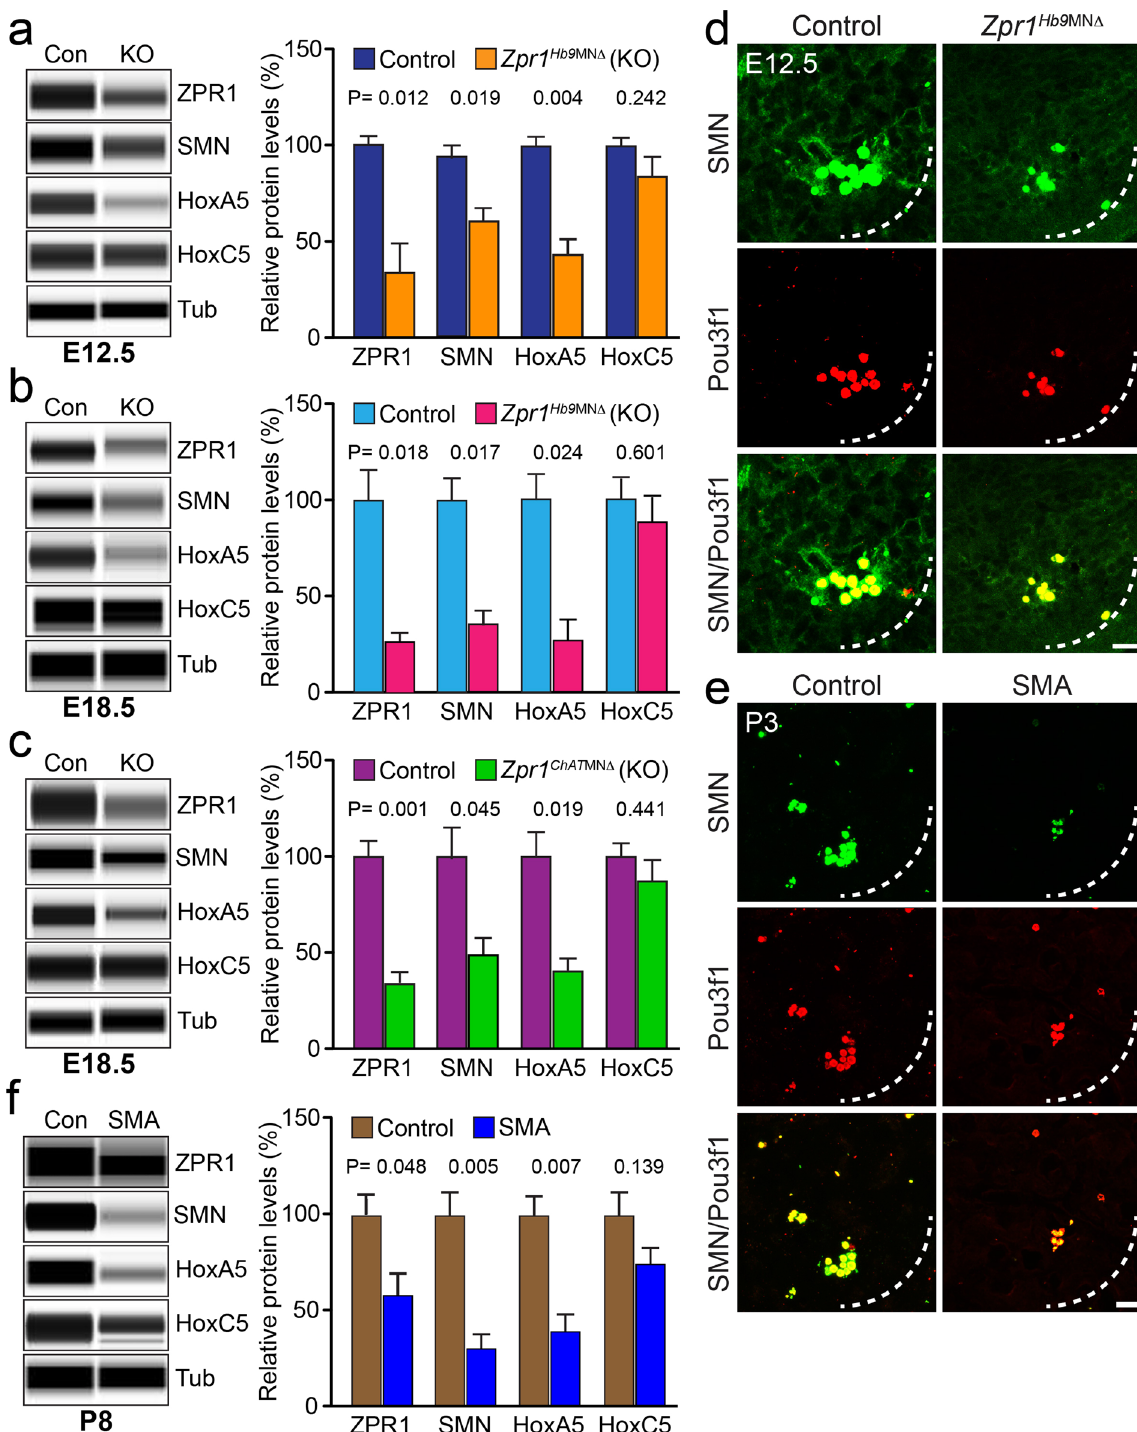
Figure 8. Deregulation of ZPR1 results in down regulation of HoxA5 that causes respiratory distress in Zpr1 mutant and SMA mice. Protein levels of ZPR1, SMN, HoxA5 and HoxC5 were examined in the spinal cords from control and mutant E12.5 and E18.5 embryos using automated Protein Wes System (ProteinSimple) and quantification was performed using Compass software. Quantitative analysis (mean ± s.e.m., n = 3 mice/ group) of protein levels show that Zpr1 mutation resulted in reduced protein levels in ( a ) E12.5 embryos ZPR1 (47.44 ± 11.98%, p = 0.012), SMN (73.13 ± 5.14%, p = 0.019), HoxA5 (43.62 ± 8.84%, p = 0.004) and HoxC5 (87.23 ± 8.81%, p = 0.242) and ( b ) E18.5 embryos ZPR1 (27.67 ± 4.97%, p = 0.010), SMN (35.33 ± 7.86%, p = 0.011), HoxA5 (29.00 ± 10.44%, p = 0.024) and HoxC5 (89.00 ± 14.22%, p = 0.637) of Zpr1 Hb9 MN Δ mice compared to control mice. ( c ) Protein levels in Zpr1 ChAT MN Δ mice also shows reduced levels for